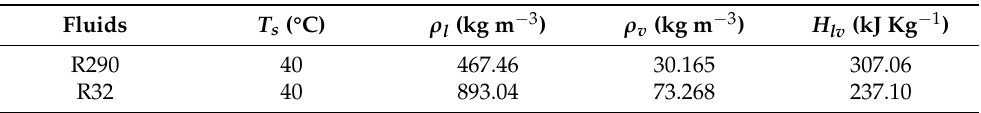
Table 7. Thermophysical properties of R290 and